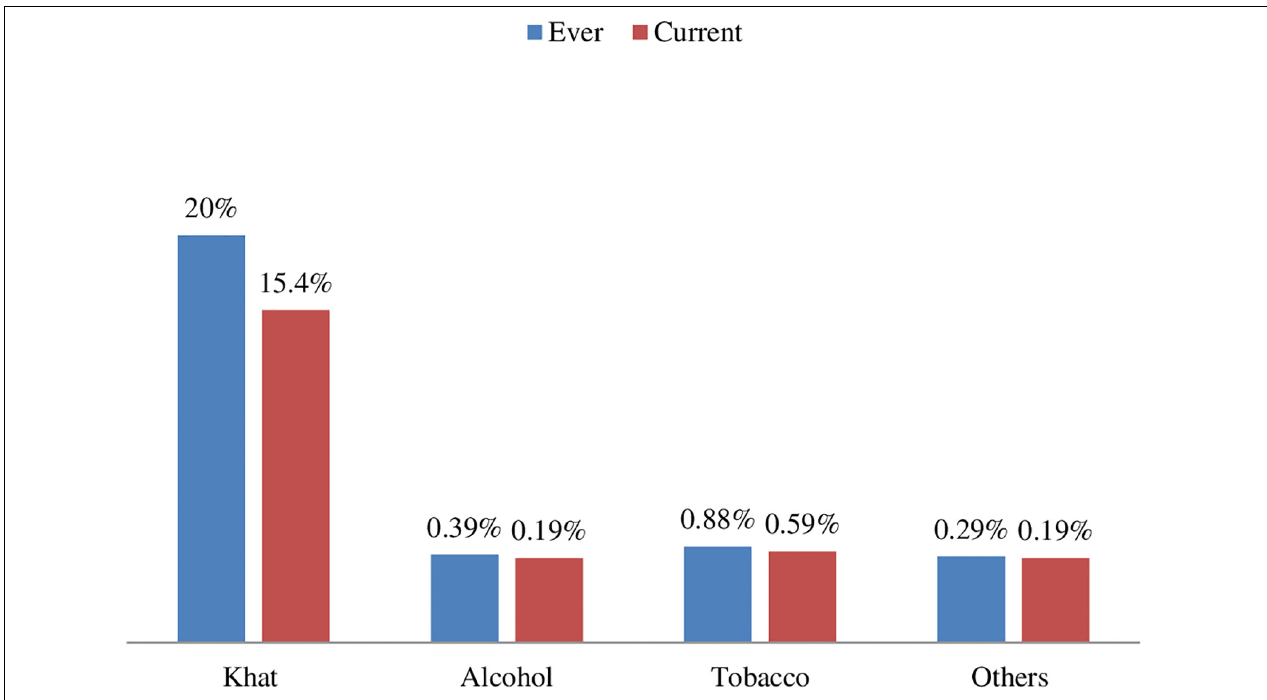
FIGURE 1 | Description of the types of substance used by pregnant